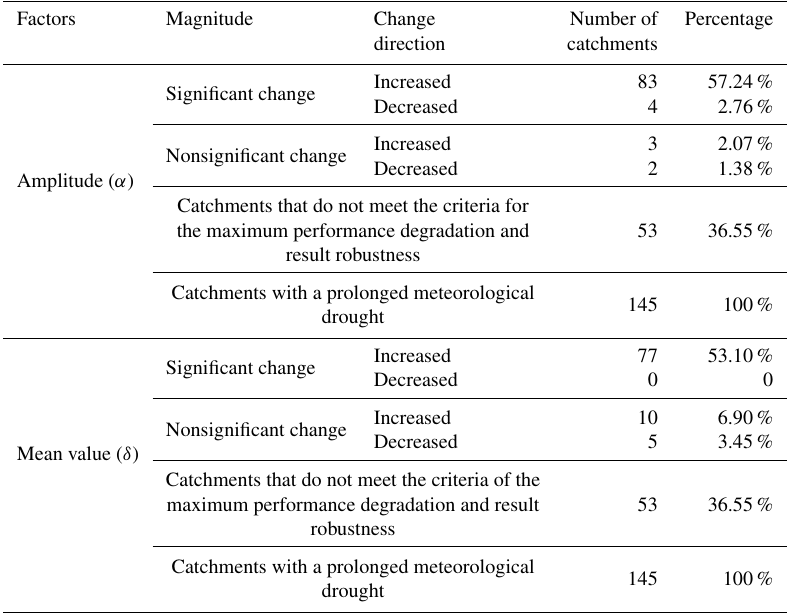
Table 5. Summary of catchments with different change patterns in the amplitude α and mean value δ in the regression function of the ACWSC due to a prolonged meteorological